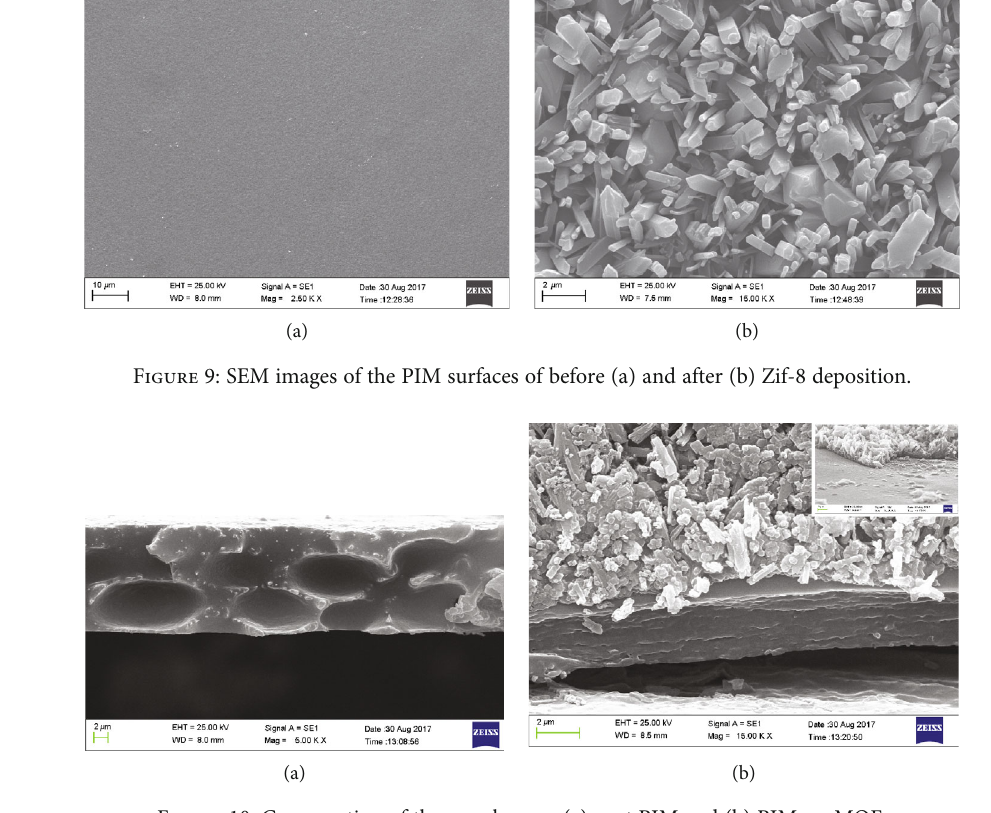
Figure 10: Cross-section of the membranes: (a) neat PIM and (b) PIM-co-MOF.